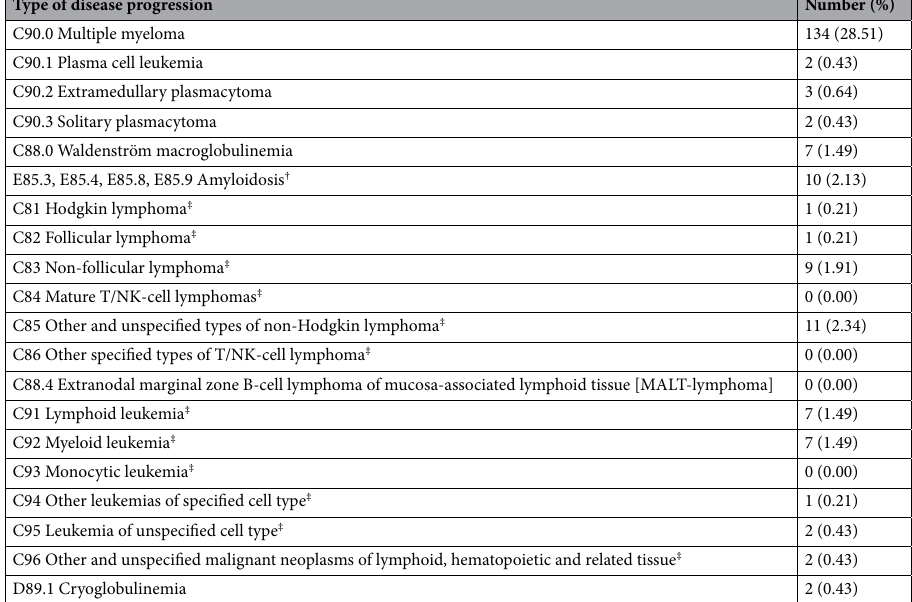
Type of disease